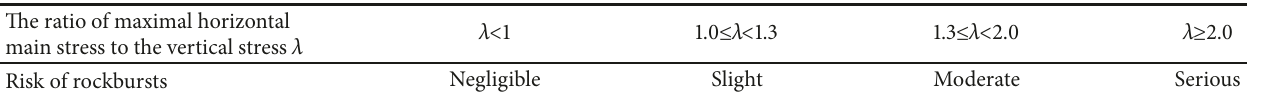
Table 3: Relationship between 𝜆 value and rockburst risk.